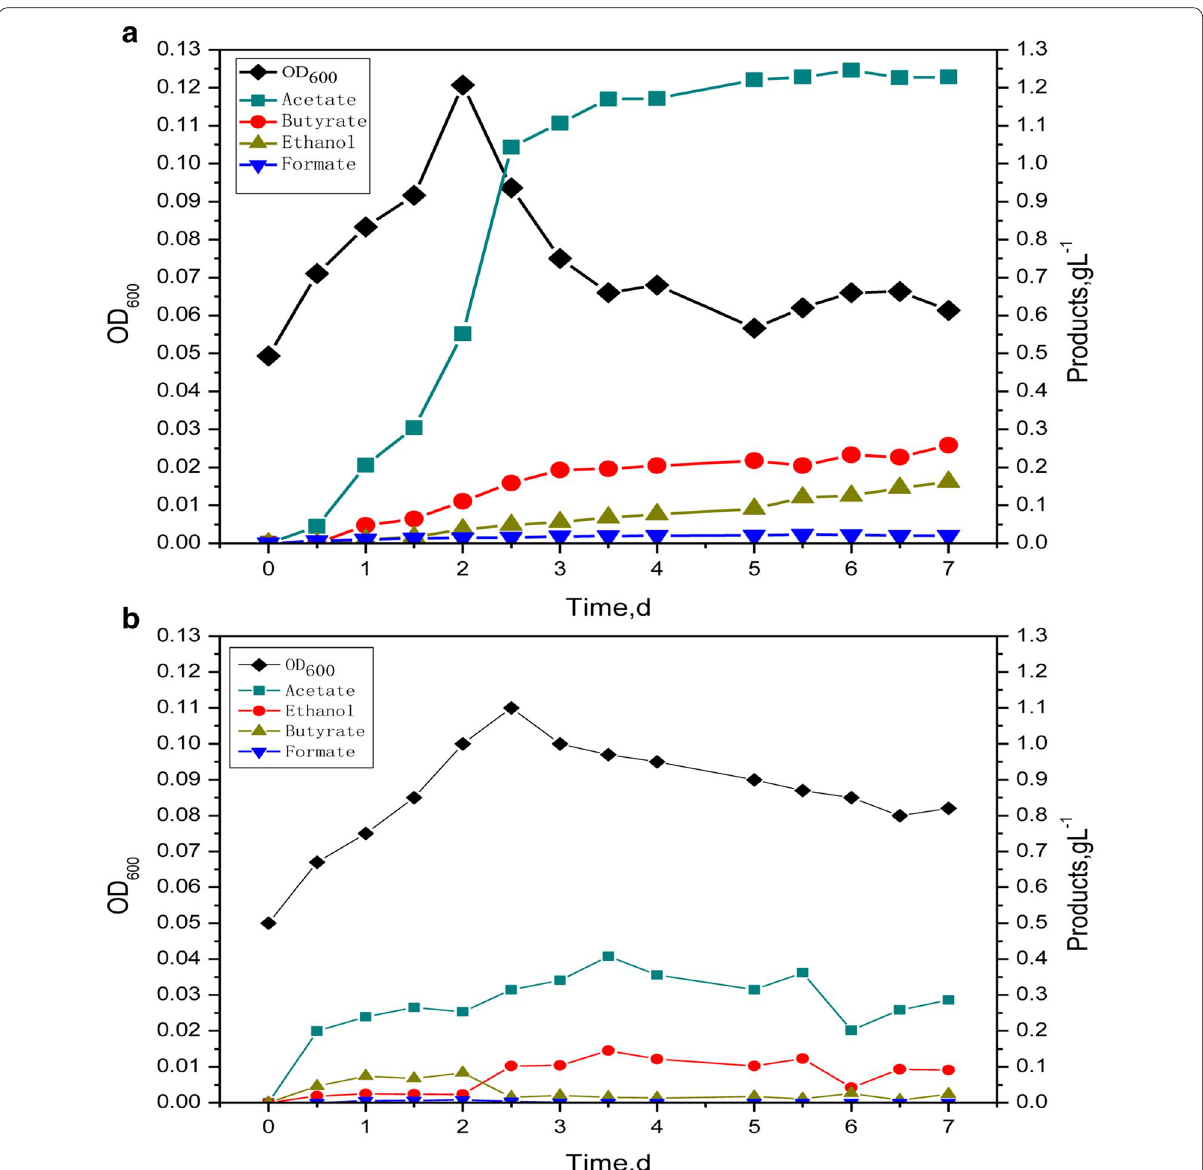
Fig. 1 OD 600 and products formation from hydrogen autotrophic fermentation using C. scatologenes ATCC 25775: ( a ) the autotrophic fermentation of C. scatologenes ATCC 25775 by mixture gas (H 2 /CO 2 ,(80/20, v/v)) ( b ) the autotrophic fermentation of C. scatologenes ATCC 25775 by mixture gas (H 2 /CO 2 /N 2 ,(10/10/80,